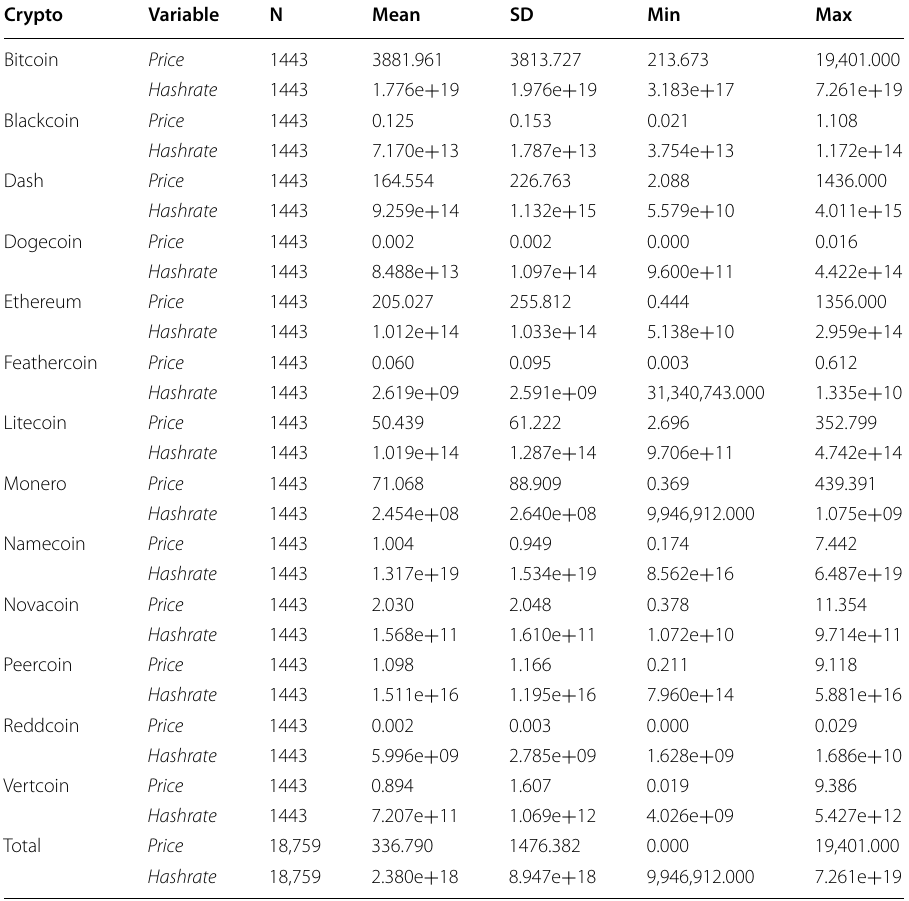
Table 2 Summary